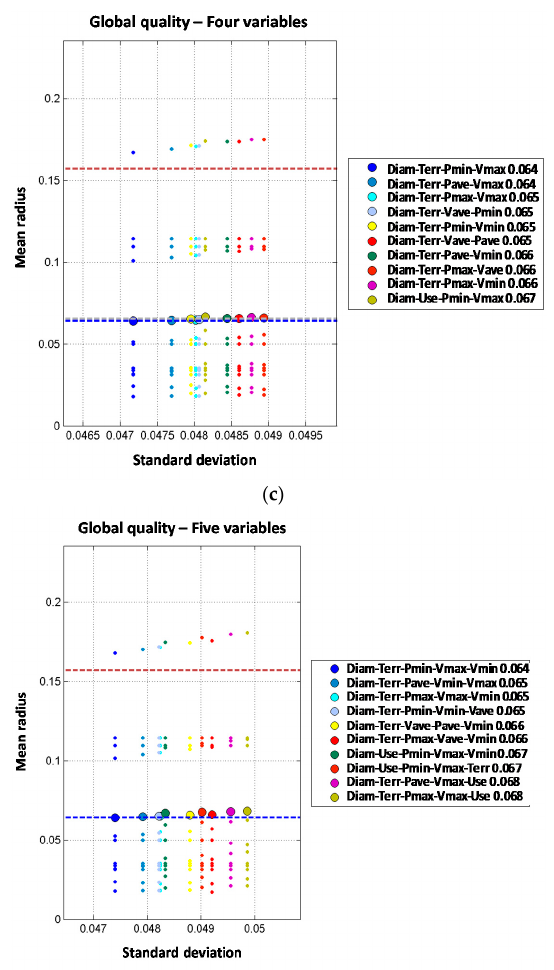
Figure 4. Distribution lines. Mean radius and standard deviation for models with all independent variables. Order zero mean radius is represented with brown dotted line; and best predictive model with blue line for: ( a ) order two; ( b ) order three; ( c ) order four; and ( d ) order five models. Water 2017 , 9 , 158